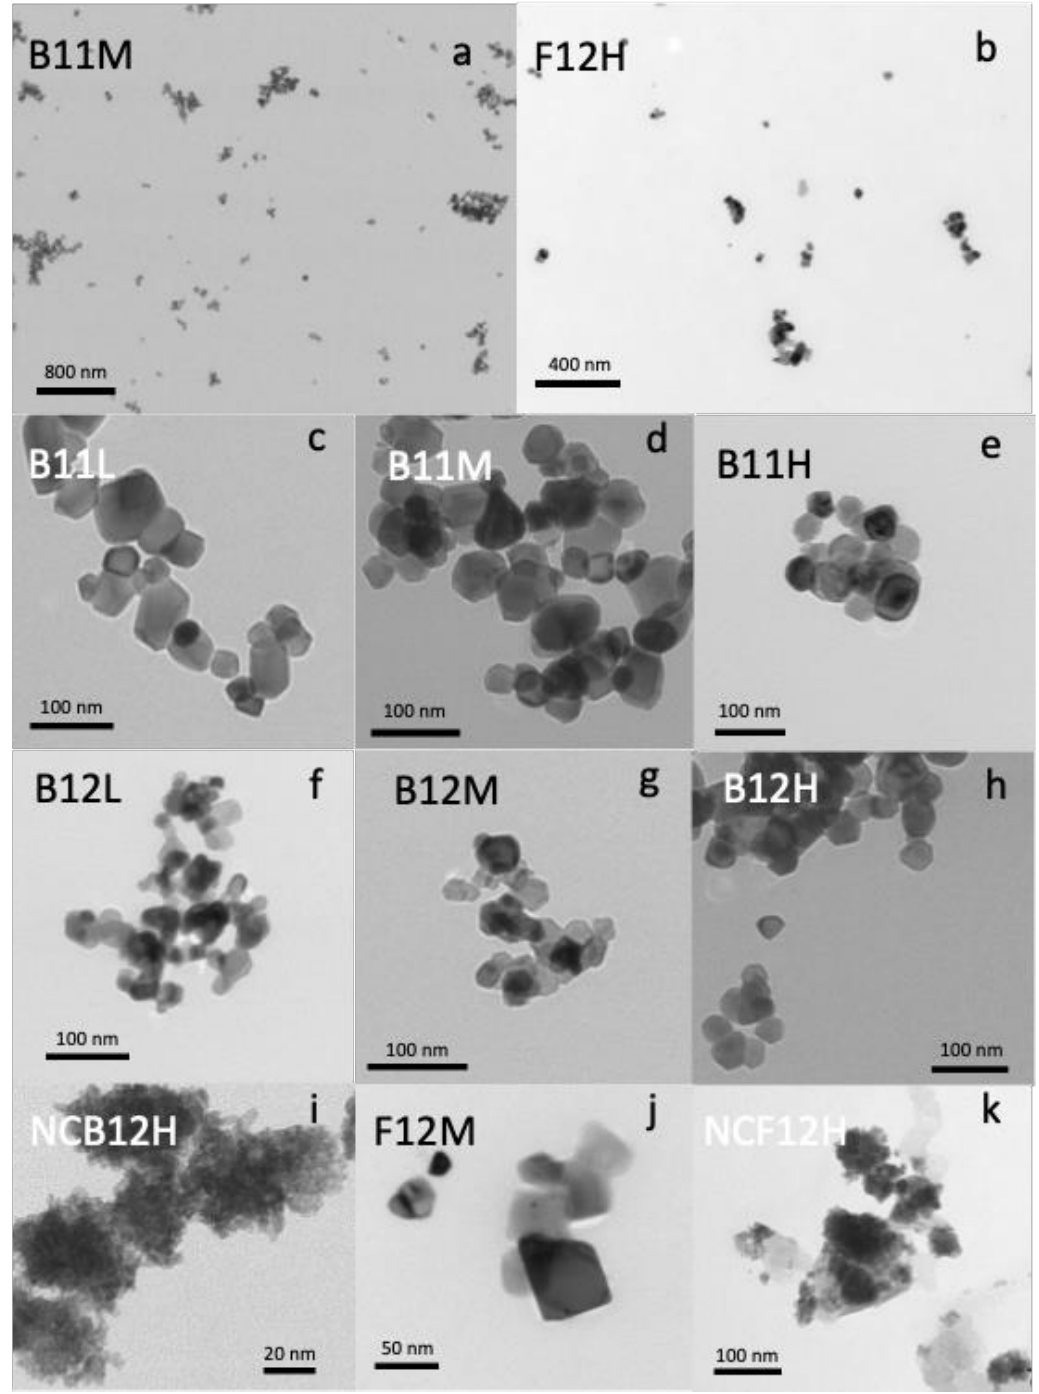
Figure 2. TEM images of the CeO 2 materials: ( a ) general view of B11M, ( b ) F12H, ( c ) B11L, ( d ) B11M, ( e ) B11H, ( f ) B12L, ( g ) B12M, ( h ) B12H, ( i ) NCB12H, ( j ) F12H, and ( k ) NCF12H. B (batch); F (flow); 11 or 12 indicates the pH; L, M, or H for low (50 W), medium (100 W), or high (200 W) power. NC is added before the name for the non-calcined materials.